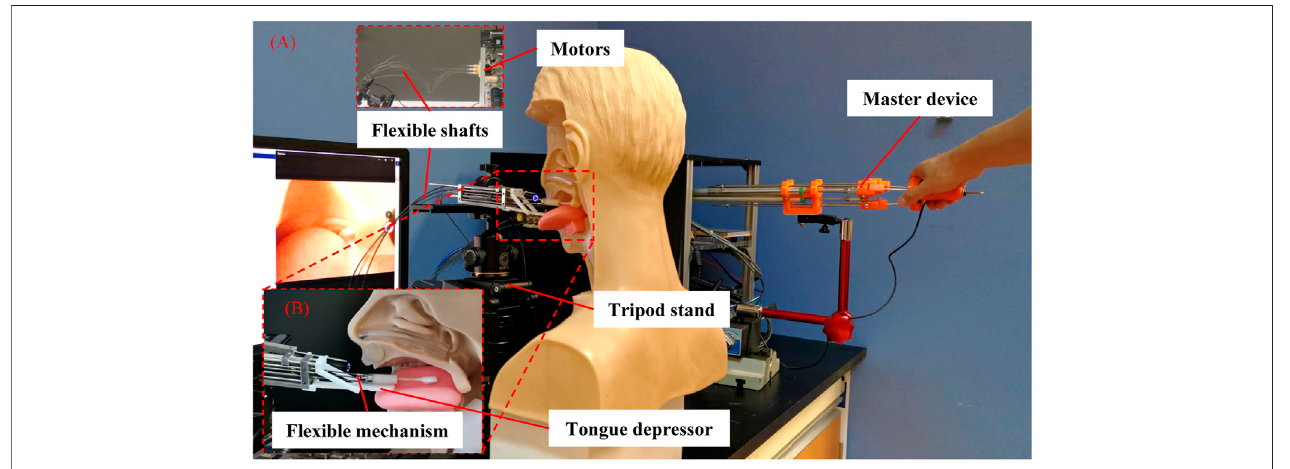
FIGURE 1 | Flexible transoral robot. (A) The robotic system; (B) The fl exible